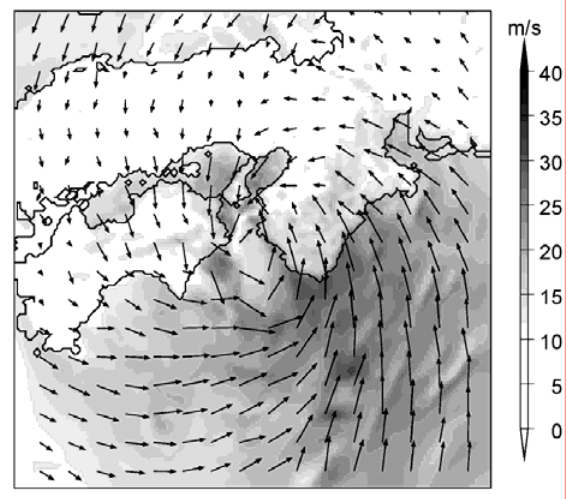
Figure 4. Distribution of the horizontal wind vectors from the lowest layer in Domain 2, approximately 11 m above the ground surface. 1330 LST, 22 September,